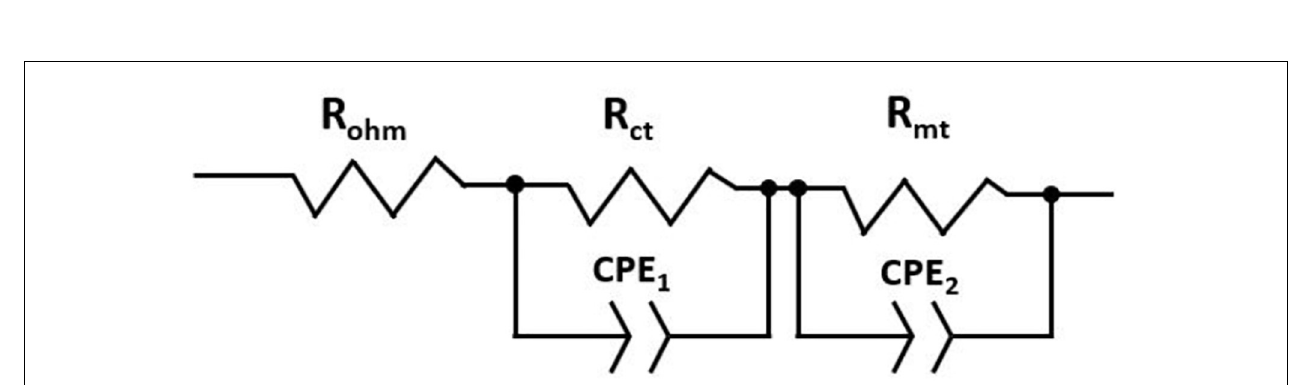
FIGURE 3 | Equivalent circuit representing a single fuel cell constituted by resistors and constant phase elements.